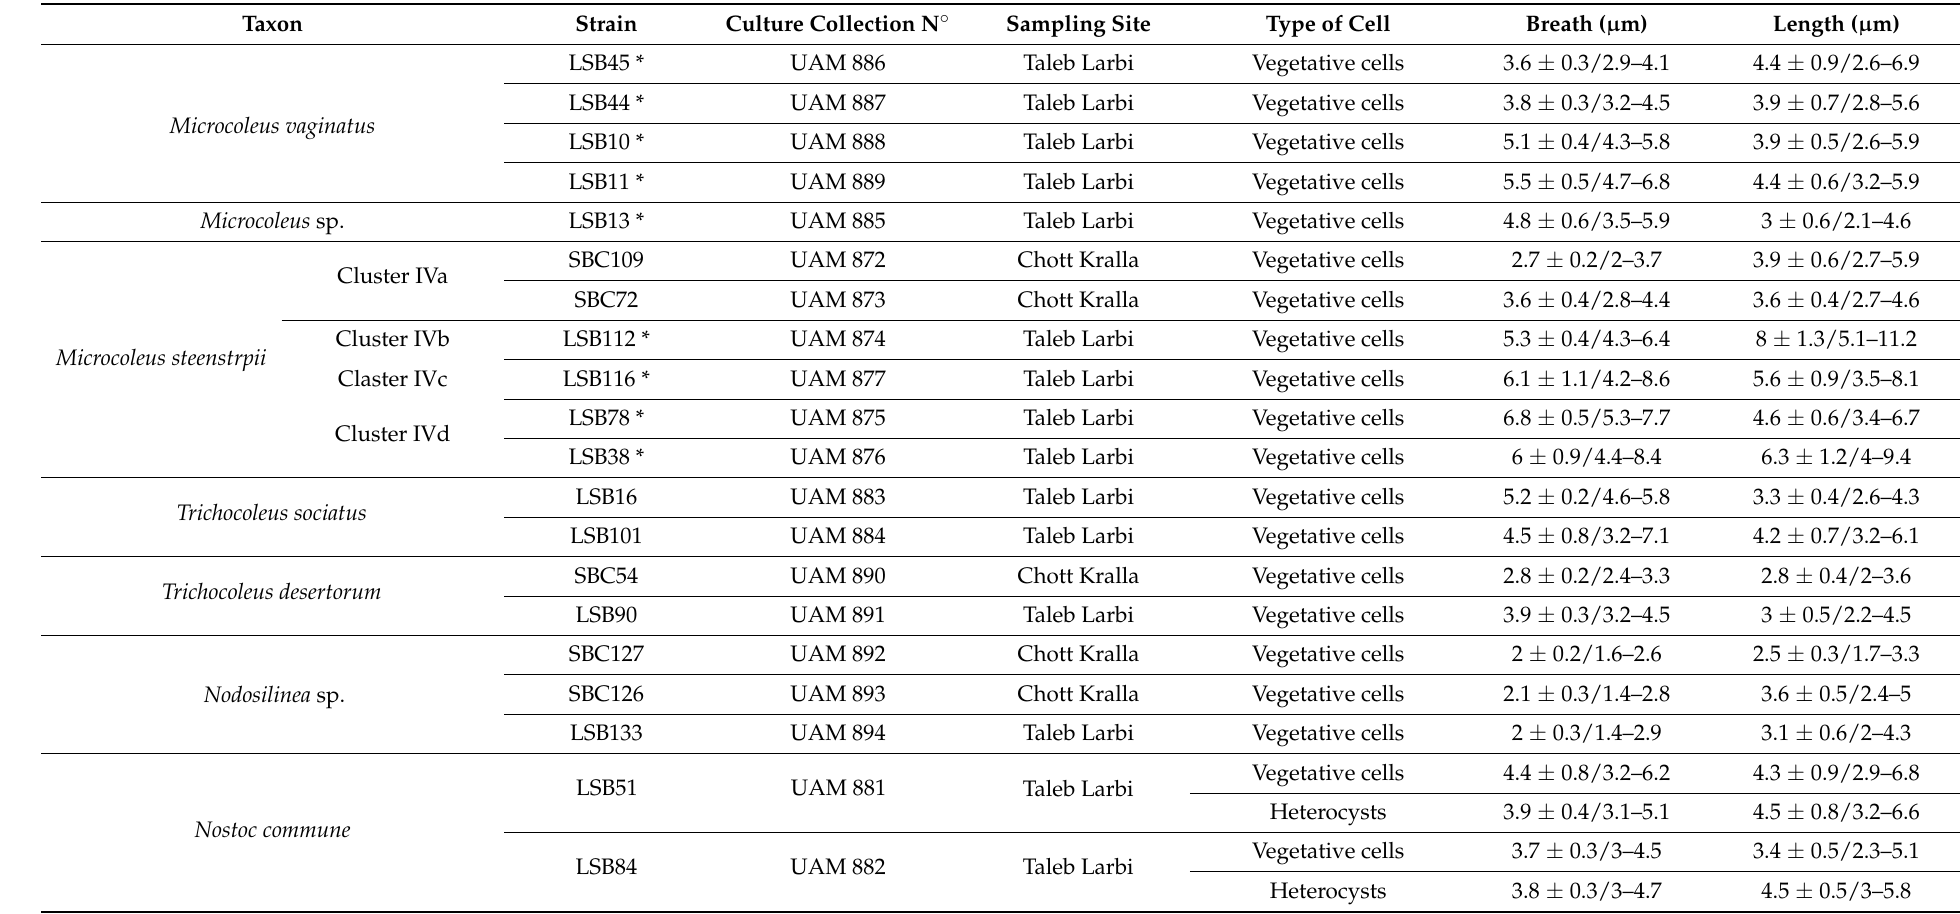
Table 2. Morphological characteristics of cyanobacterial cells. Measurements are given as mean ± standar deviation/range, n = 100. * Isolated from bundles. (SBC, Saline biocrusts; LSB, Less saline